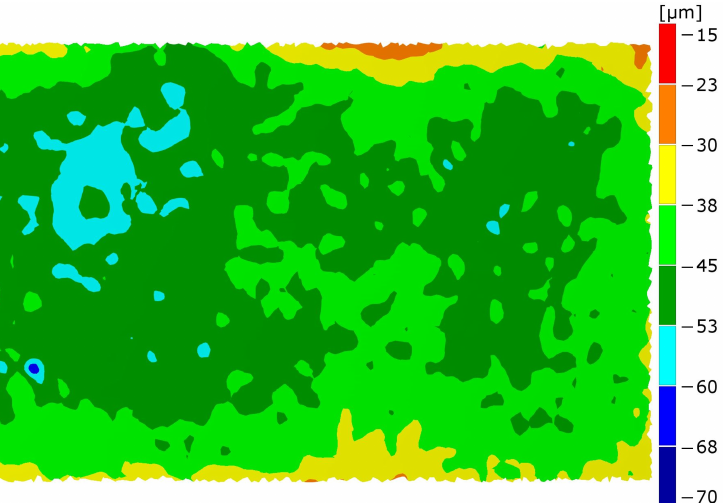
Figure 9. Surface error of final scanned SiC part to the planned CAD in the defined WCS using GOM scan